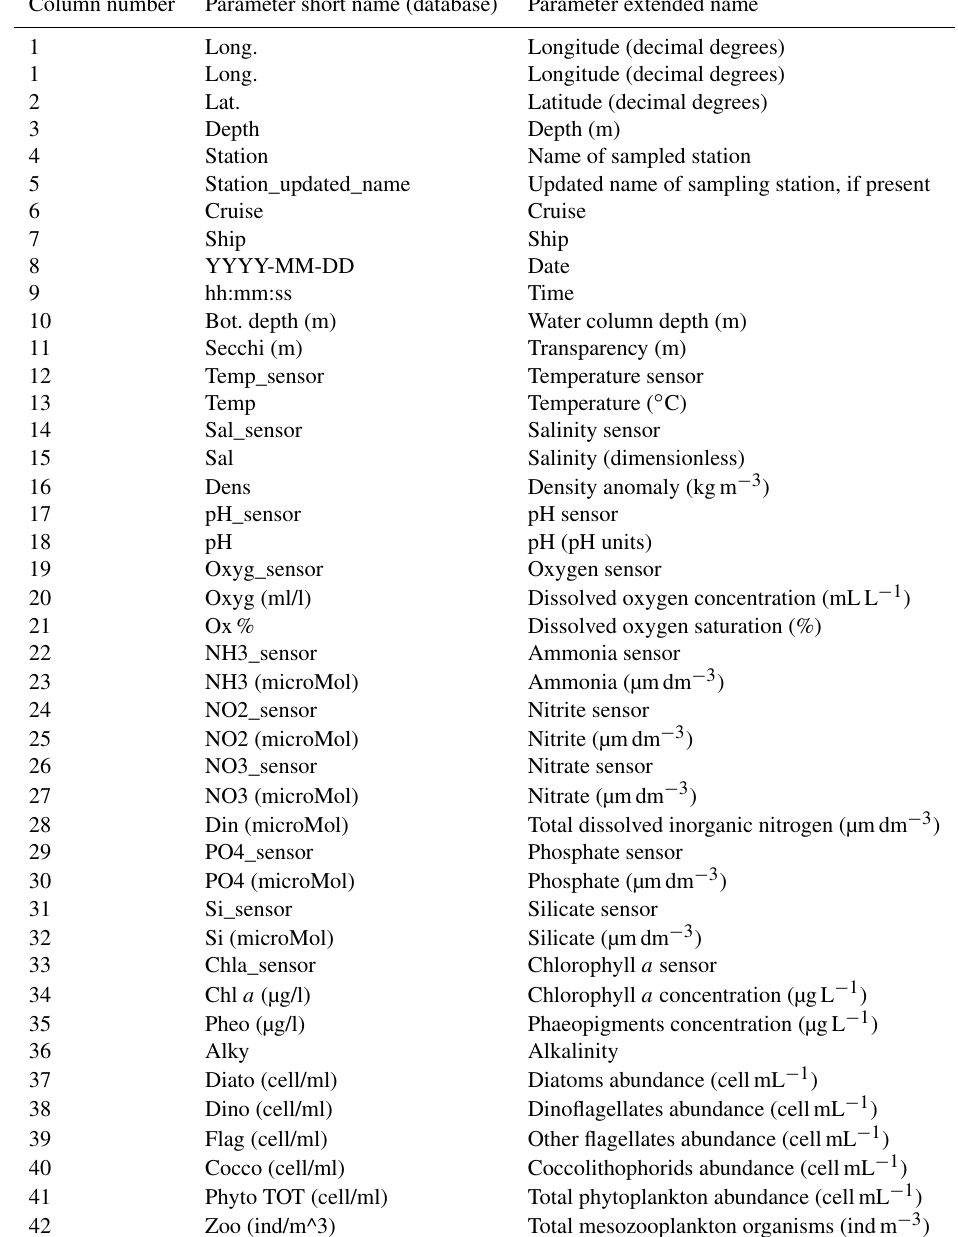
Table 4. Correspondence between column number, short name, and extended name of each parameter reported into the database. Column